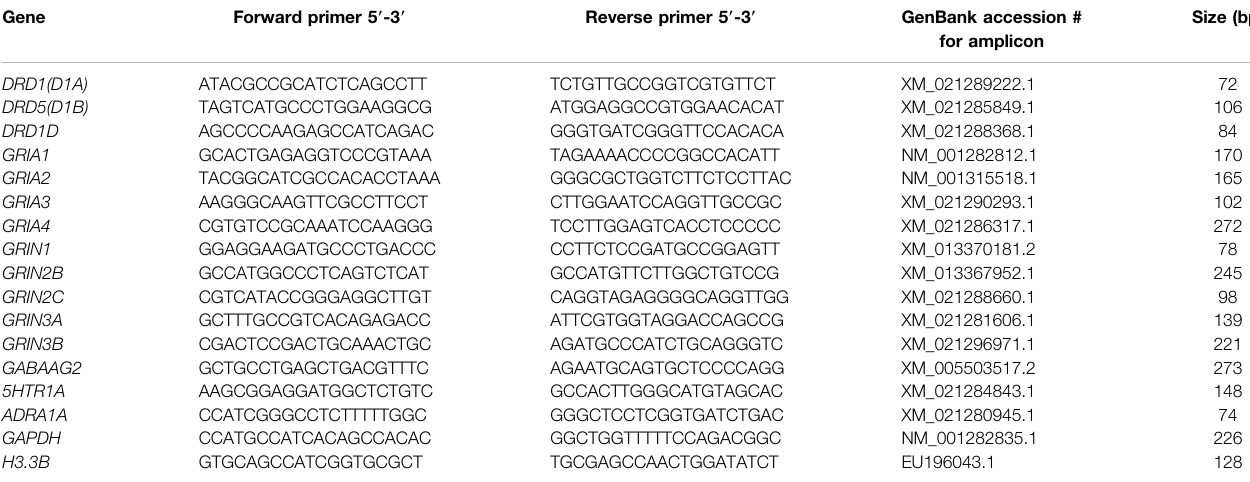
TABLE1| PrimerpairsusedforquantitativeRT-PCR.Eachprimerpairbindsspeci fi callytheindicatedgenewithoutcross-reactions.Theobtainedfragmentswereveri fi edby sequence